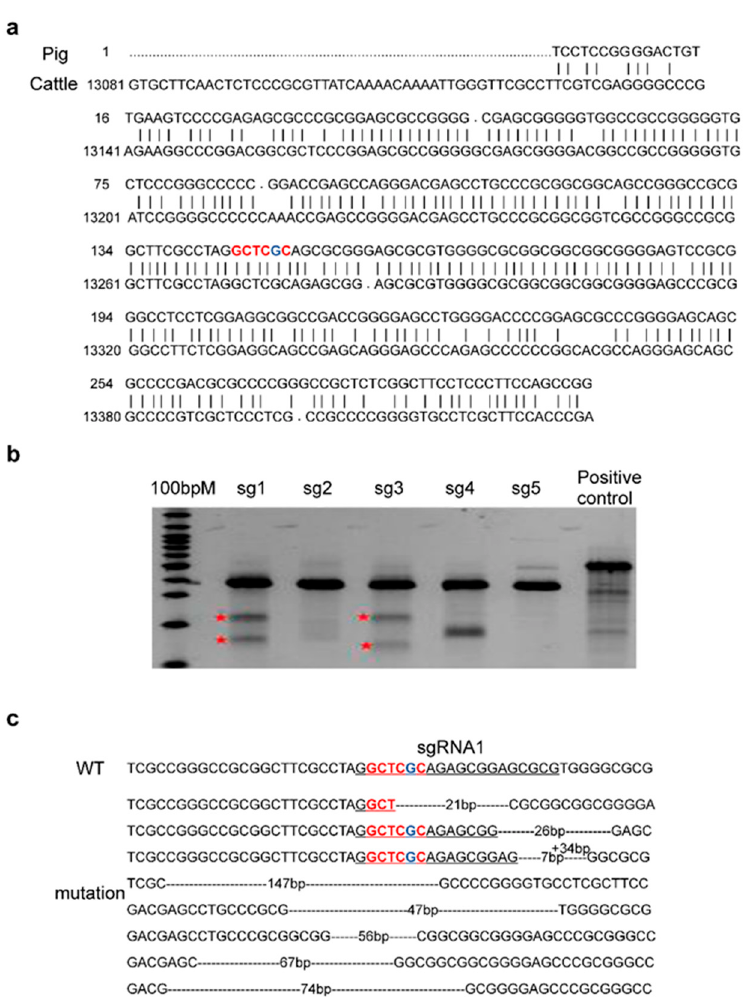
Figure 1. Prediction of the ZBED6-binding site in bovine IGF2 , and determination of sgRNA mutation efficiency: ( a ) Identification of the ZBED6-binding site in bovine IGF2 intron 3 using homologous alignment. The upper bases of each line are the porcine IGF2 sequence; the lower bases of each line are the bovine IGF2 sequence. ( b ) Determination of the mutation efficiency of five pairs of sgRNA by T7 endonuclease 1 digestion. The red asterisk marks the fragments digested by T7 endonuclease 1. ( c ) Determination of the mutation efficiency of sgRNA1 using TA cloning. Bases in red represent the ZBED6-binding site, the base in blue represents the key base of the ZBED6-binding site, underlined bases indicate sgRNA, and dashed lines represent base deletion.